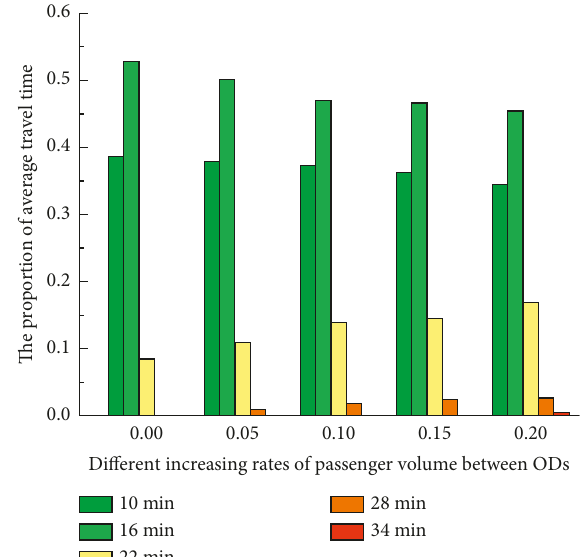
Figure 12: The proportion distribution of average travel time under different increasing rates of passenger volume between OD